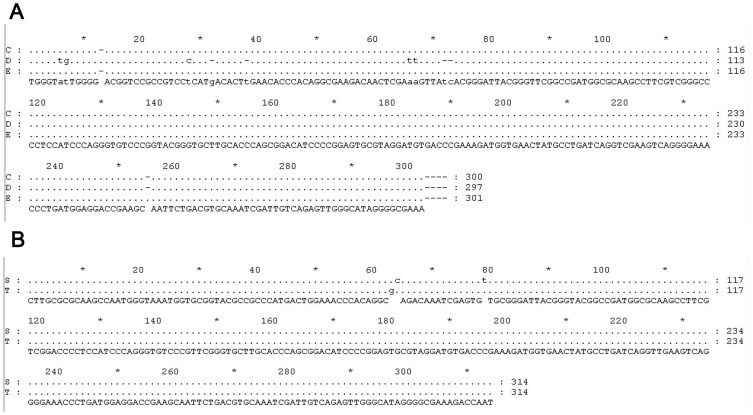
(a) Nucleotide alignment of Anopheles culicifacies species complex (GenBank database accession numbers KC494261, KC494262 & KC494264); (b) Nucleotide alignment of Anopheles fluviatilis species complex (GenBank database accession numbers KC 345546 & KC345547).